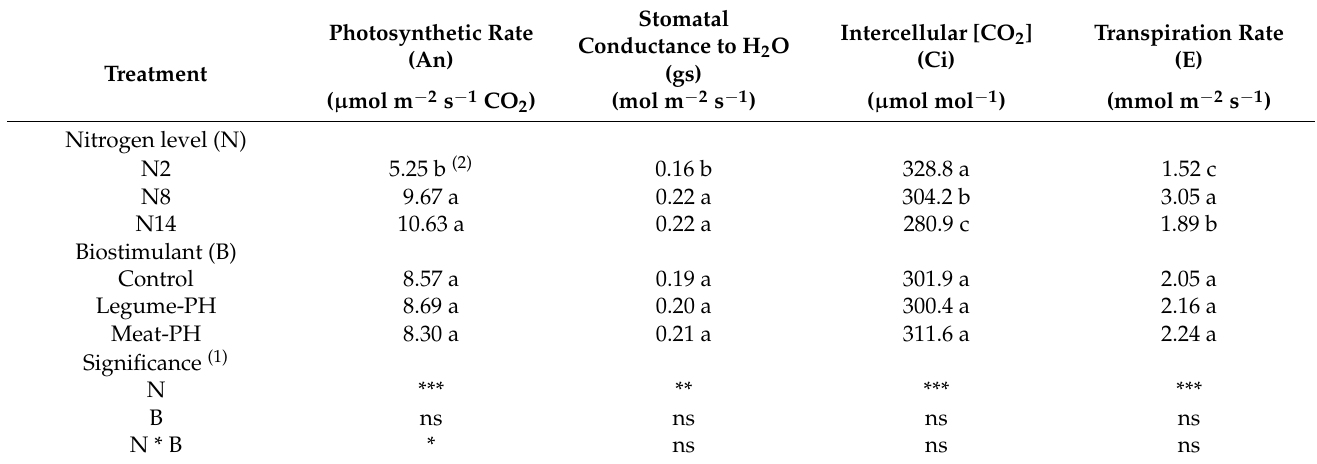
Table 3. Leaf gas exchange of spinach as affected by nitrogen nutrition and by foliar application of biostimulants.